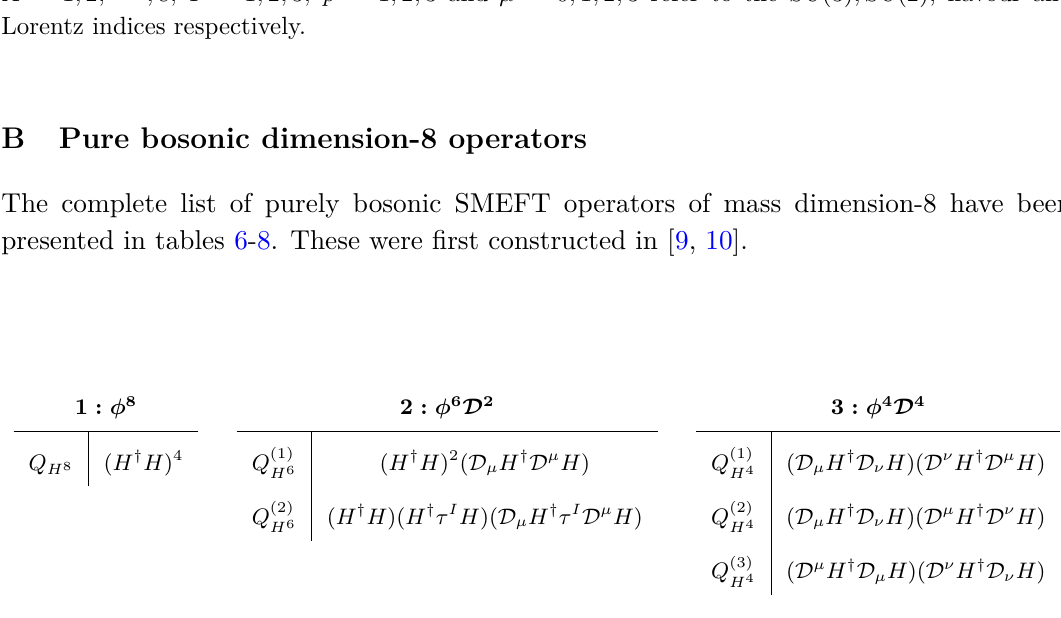
Table 6. The dimension-8 SMEFT operators with only the SM scalar, its conjugate and their derivatives as the building